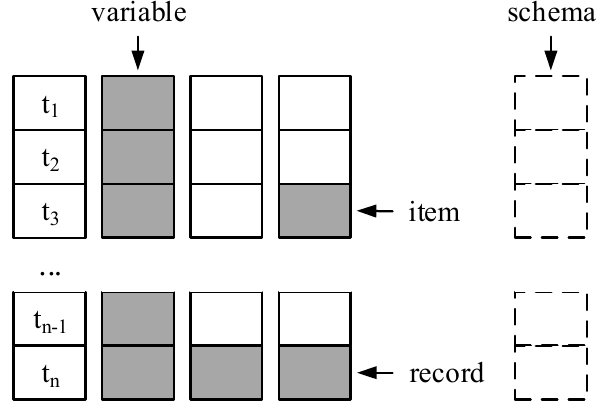
Figure 4. Data hierarchy is used to classify different attributes of completeness.